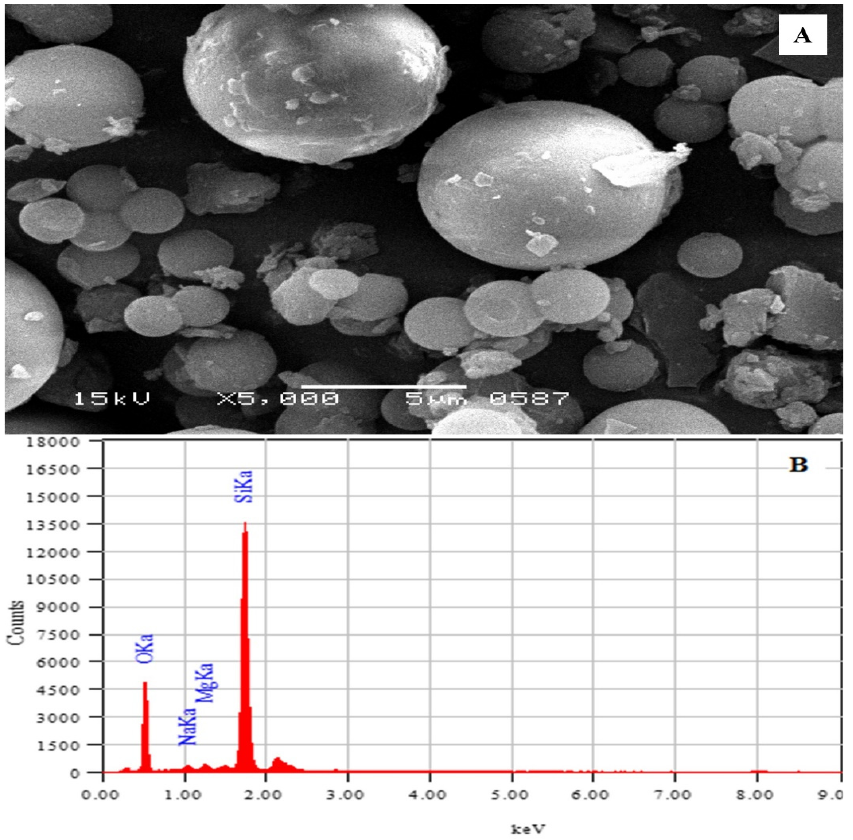
Figure 1. ( A ) Scanning electron image; ( B ) EDAX spectra of magnetic iron oxide nanoparticles. 2.2. Optimization of Immobilization Parameters of Pectinase on Magnetic Iron Nanoparticles